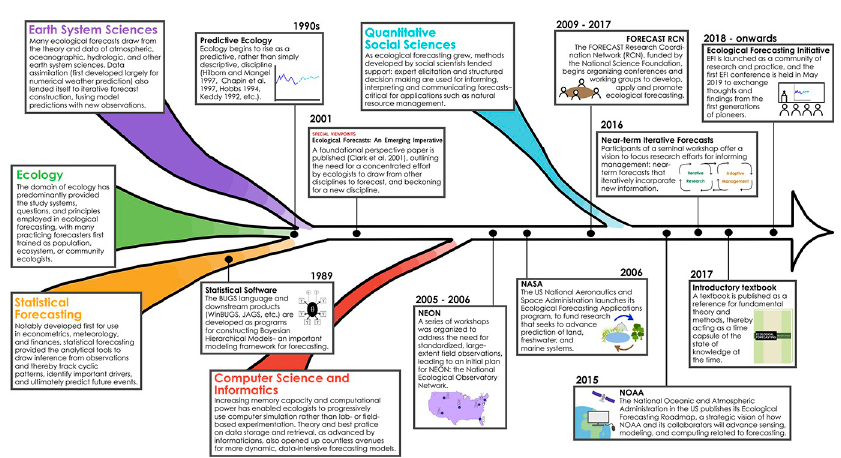
Fig 2. Timeline of the development of ecological forecasting, an emerging field that combines methods, data, and theory from a number of parent fields. Some of the milestones in the field are provided as examples of the accumulation of resources and community building that has occurred thus